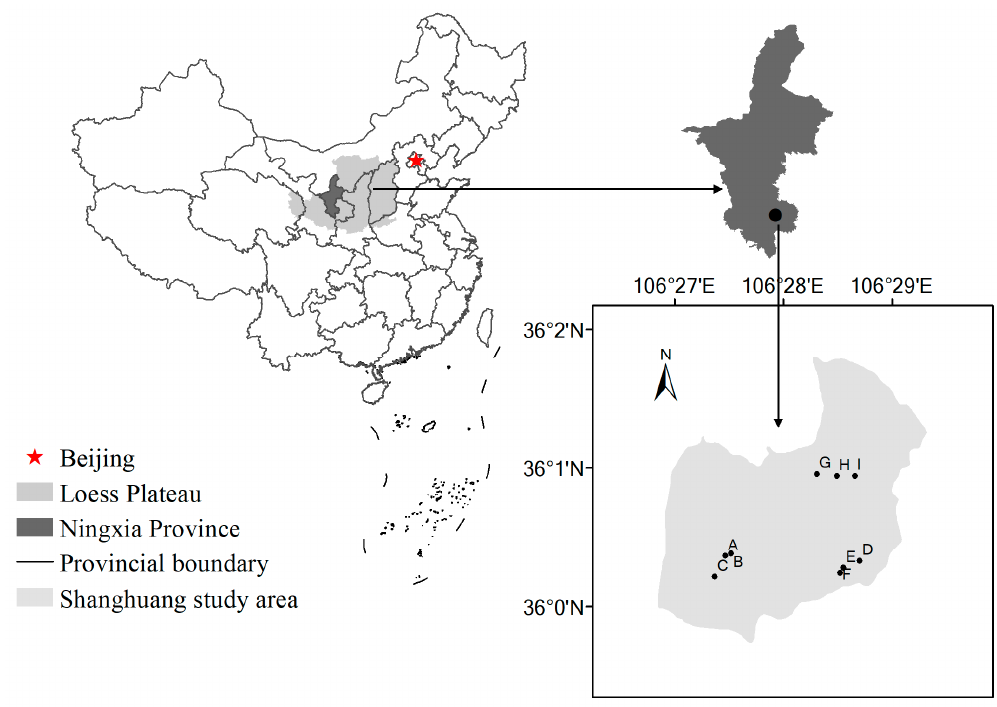
Figure 1. The location of the study area and sampling sites: ( A – C ) cropland; ( D – F ) 26-year-old C. korshinskii ; in addition to ( G – I ) 16-year-old C. korshinskii .